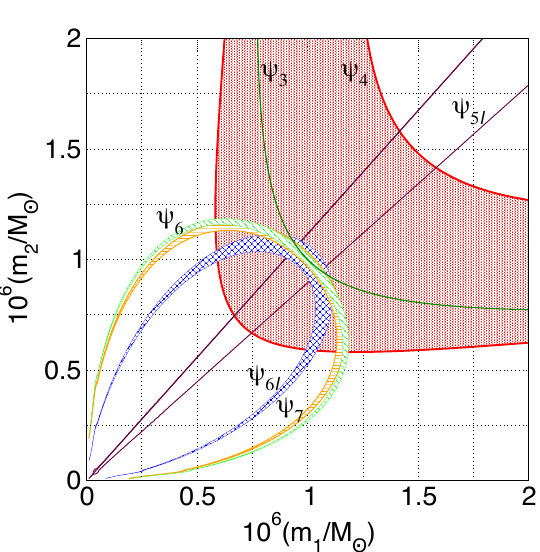
Figure 5: Estimating all the binary-inspiral phasing coefficients 𝜓 𝑘 of Eq. (51) yields differently shaped regions in the 𝑚 1 – 𝑚 2 plane, which must intersect near true mass values if GR is correct. Image reproduced by permission from [27], copyright by